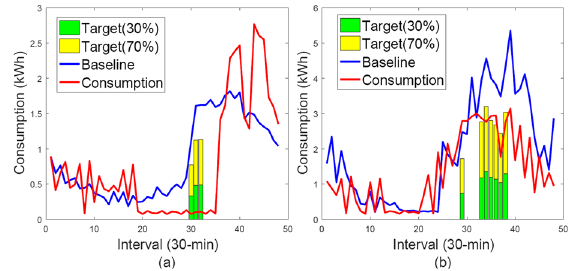
Fig. 10 Energy consumption curve for two active subjects on 7/19/2017. a Subject No. 19 (in Subgroup 1). b Subject No. 18 (in Subgroup 2)